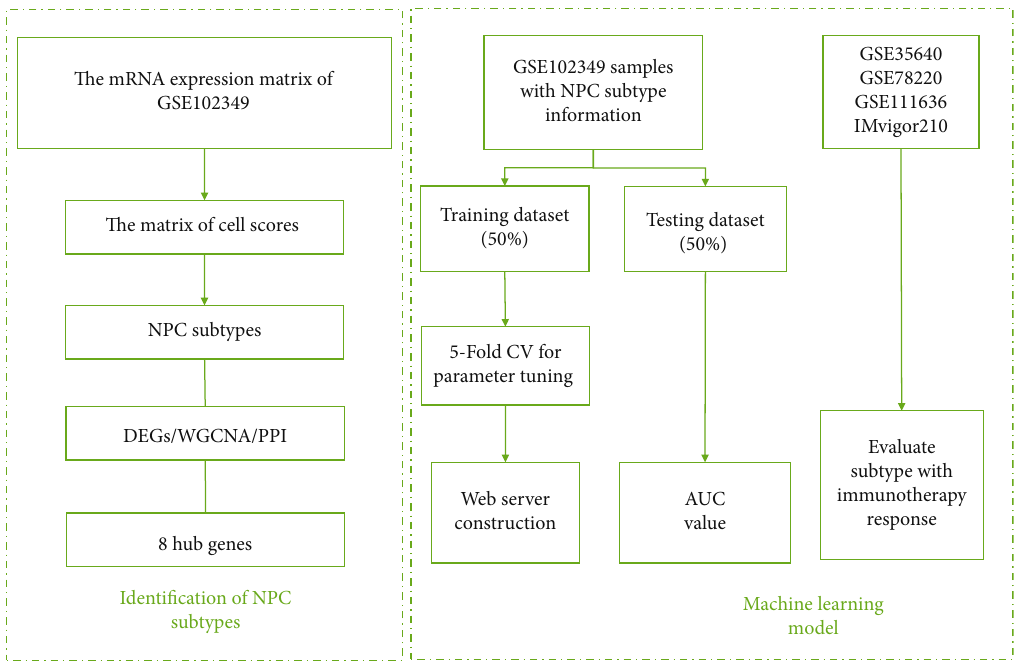
Figure 1: The fl owchart of this